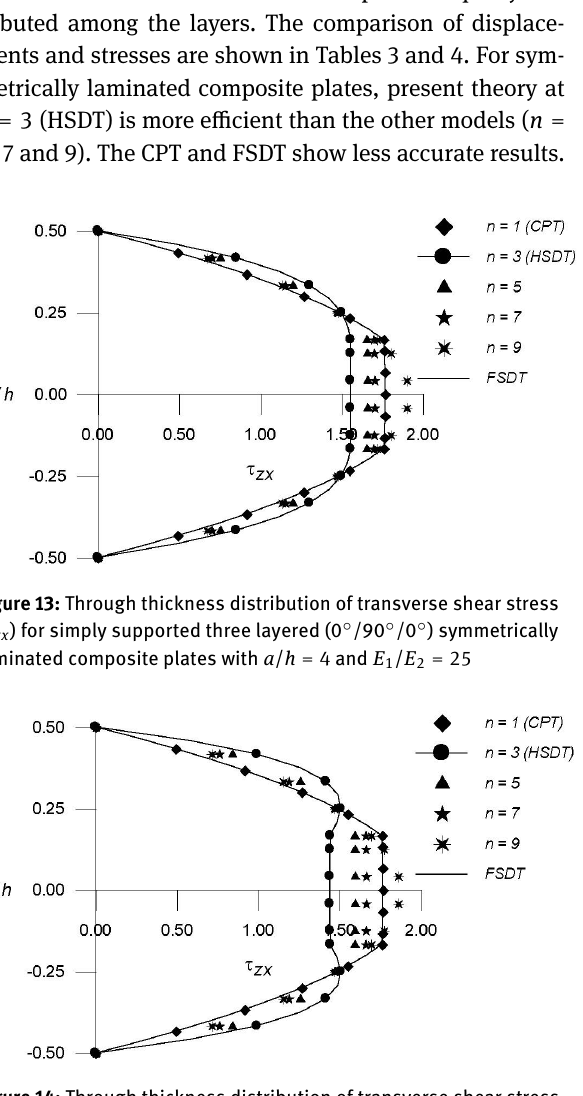
Figure 14: Through thickness distribution of transverse shear stress ( ¯ τ zx ) for simply supported three layered (0 ∘ /90 ∘ /0 ∘ ) symmetrically laminated composite plates with a / h = 4 and E 1 / E 2 =